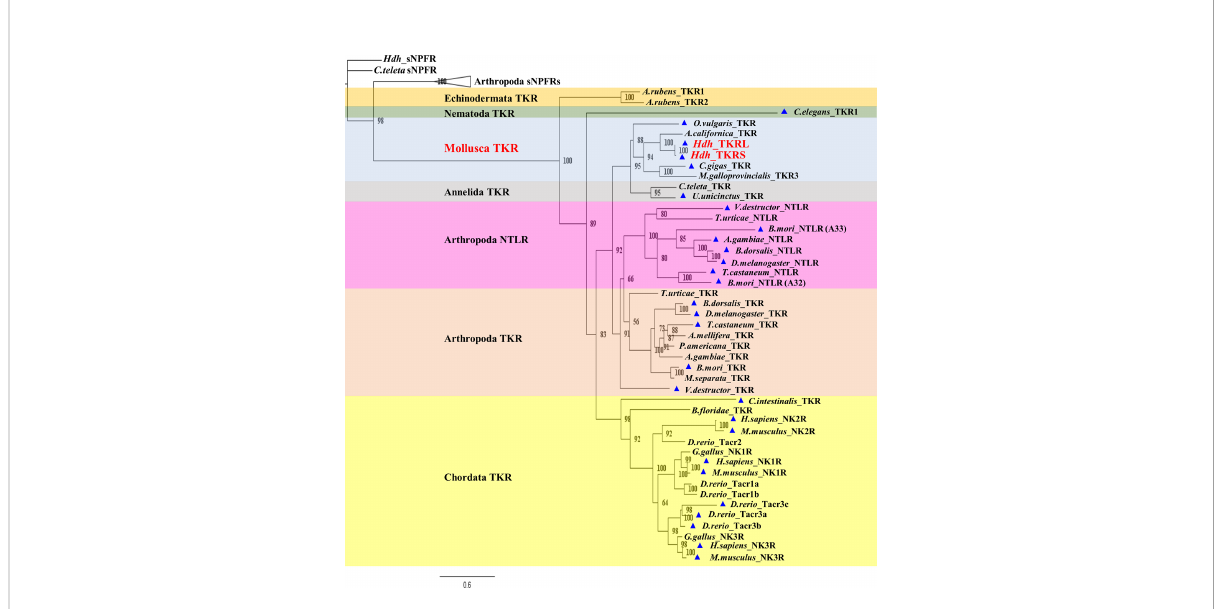
FIGURE 3 Phylogenetic tree analysis of Hdh-TKRs with bilaterian TKRs and arthropod-speci fi c NTLRs. The numbers at the branches show the bootstrap probability after 1000 iterations in constructing the tree. The lower scale bar represents 0.6 amino acid replacements per site. The blue triangle indicates receptors that have been functionally characterized. Supplementary Table 2 provides information for sequences used to generate the